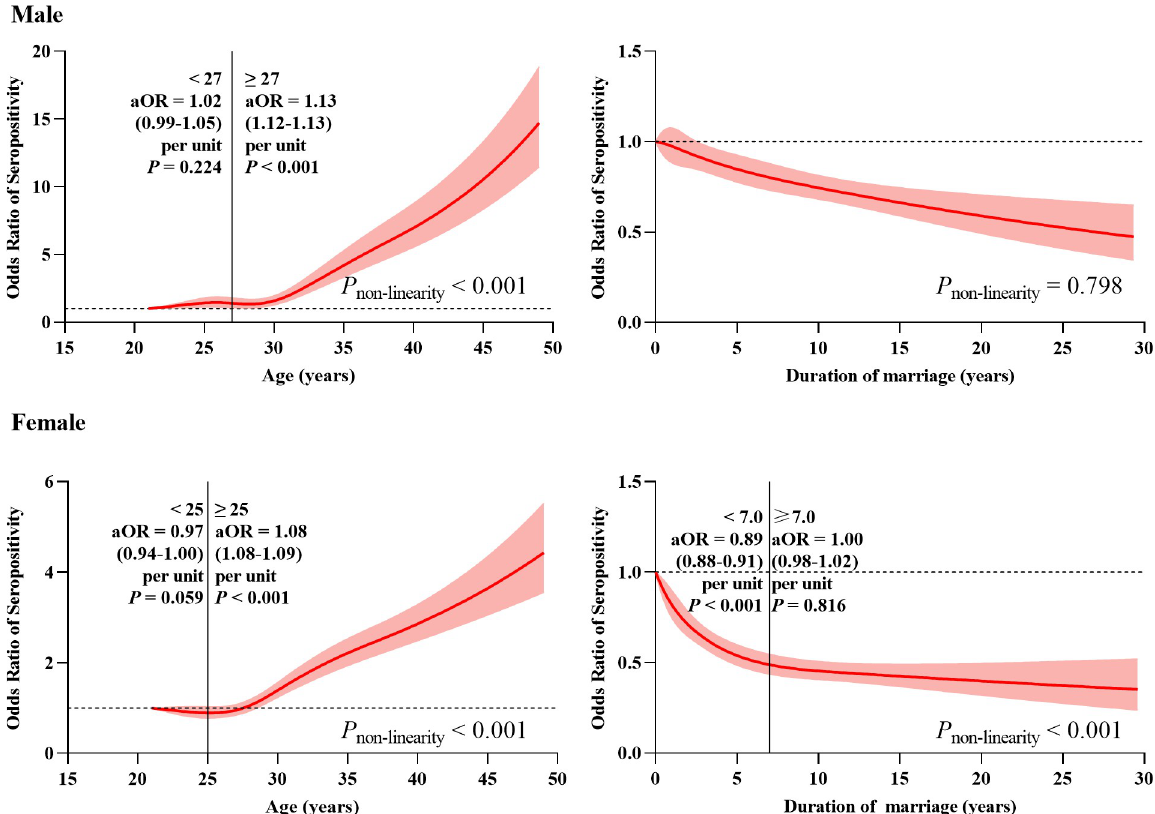
Fig 4. Association of duration of marriage and age with preconception syphilis seroprevalence among married individuals aged 21–49 years. Adjusted odds ratios (aOR) were indicated by solid lines and 95% confidence intervals by shaded areas. Duration of marriage and age were mutually adjusted in the restricted cubic splines models with five knots and the reference points were the respective minimum values. All models were adjusted for ethnicity, education, occupation, household registration, migrant, smoking, drinking, ever used drug, syphilis seropositivity of spouses and region. Additional adjustment of pregnancy history only for